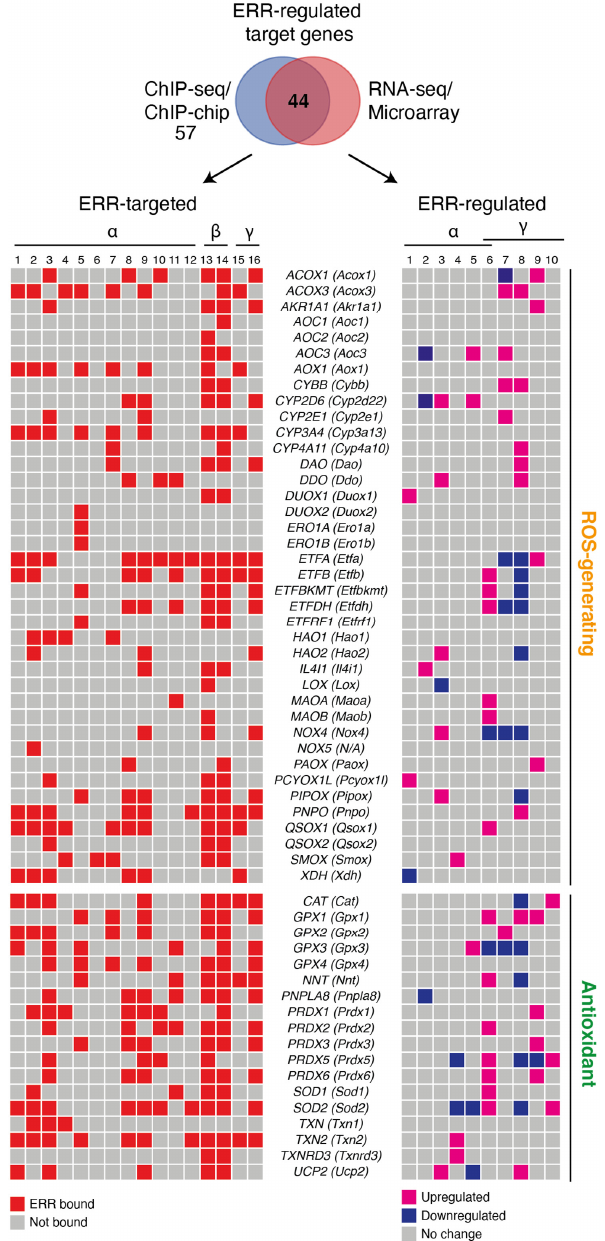
Figure 1. ERR-targeted enzymes implicated in ROS metabolism. Schemes follow the same formatting. Both human and mouse gene names are shown, the latter in parentheses. Genes implicated in